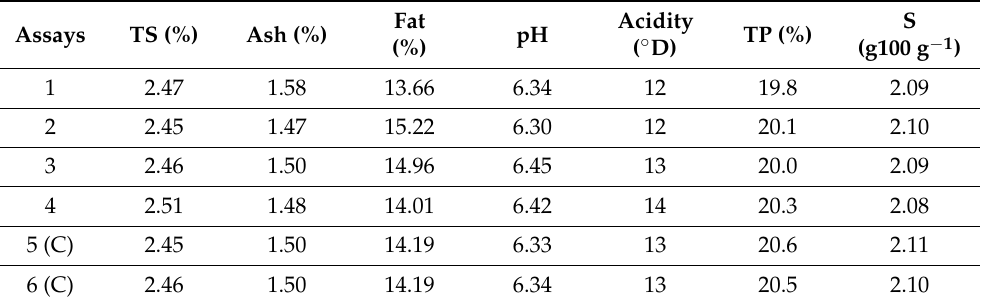
Table 2. Coated cheese samples’ physicochemical analysis: Total solids (TS), ash, fat, pH and acidity ( ◦ D) and total protein (TP) at 1 day-storage. Syneresis (S, g.100 g − 1 ) at 9 days-storage. Assays TS (%) Ash (%)